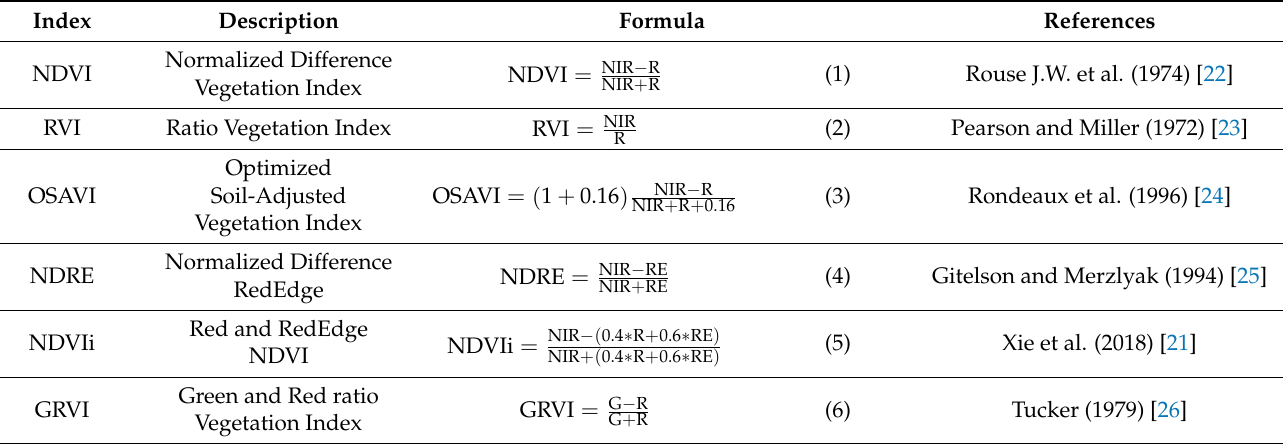
Table 3. The selection of vegetation indices used for the calculation of Water Deficit Index (WDI)